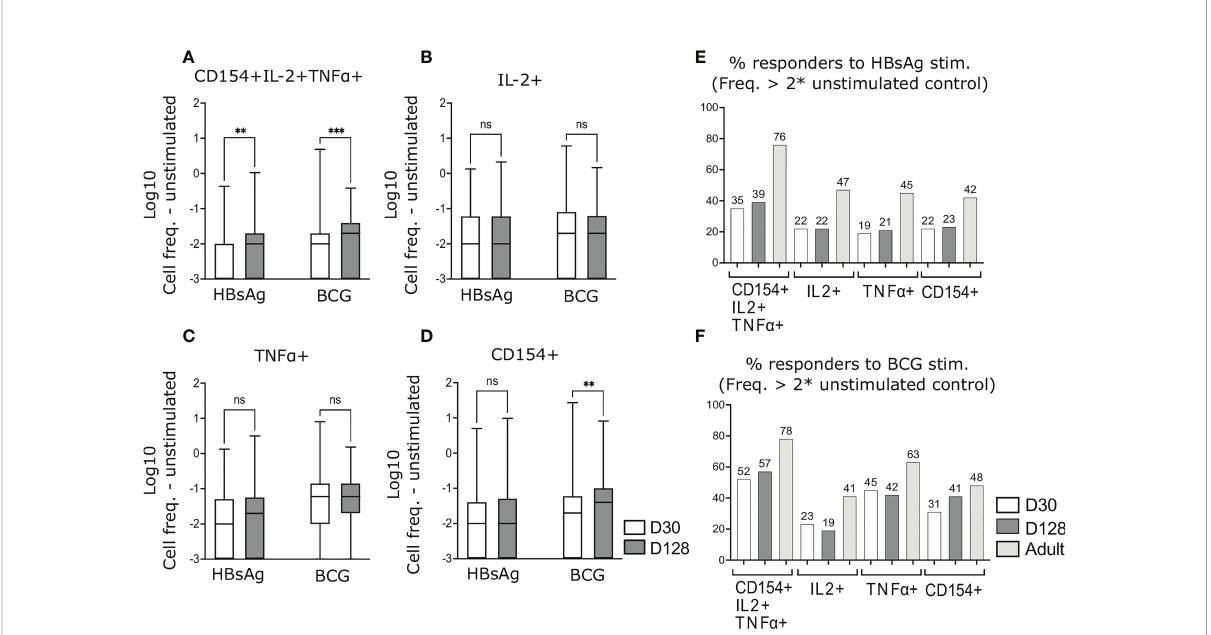
FIGURE 3 Antigen-speci fi c CD4 + T-cells following completion of HepB vaccine schedule. PBMCs from infants at D30 and D128 were stimulated and stained as in Figure 2. Background activation was removed by subtracting values from unstimulated matched samples. Cell frequencies of CD4 + polyfunctional T-cells (A) or frequencies based on total expression of IL-2 (B) , TNF a (C) or CD154 (D) were compared. Responders to HBsAg (E) and BCG (F) stimulation were calculated as having cell frequencies above 2 x of the matched unstimulated sample. (A – D) Zero and negative values were assigned a value of 0.001 to enable Log transformation. Data are expressed as Log10 of CD4 + T-cell frequencies. Kruskal-Wallis with Dunn ’ s post-test, **p < 0,01; ***p < 0,005; ns, not signi fi